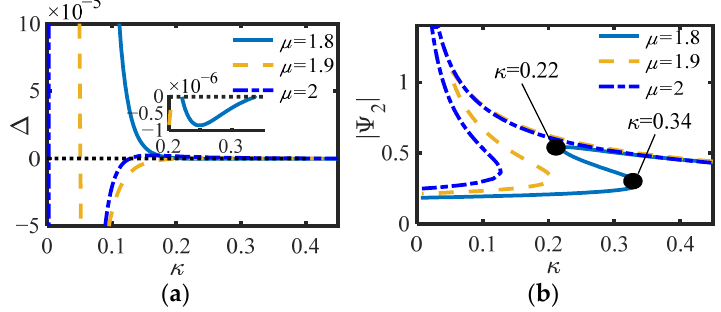
Figure 7. ( a ) Δ and ( b )| Ψ 2 | of S.1 vs. κ for different μ ( m 2 = 0.3). Figure 7. ( a ) ∆ and ( b )| Ψ 2 | of S.1 vs. κ for different µ ( m 2 = 0.3).